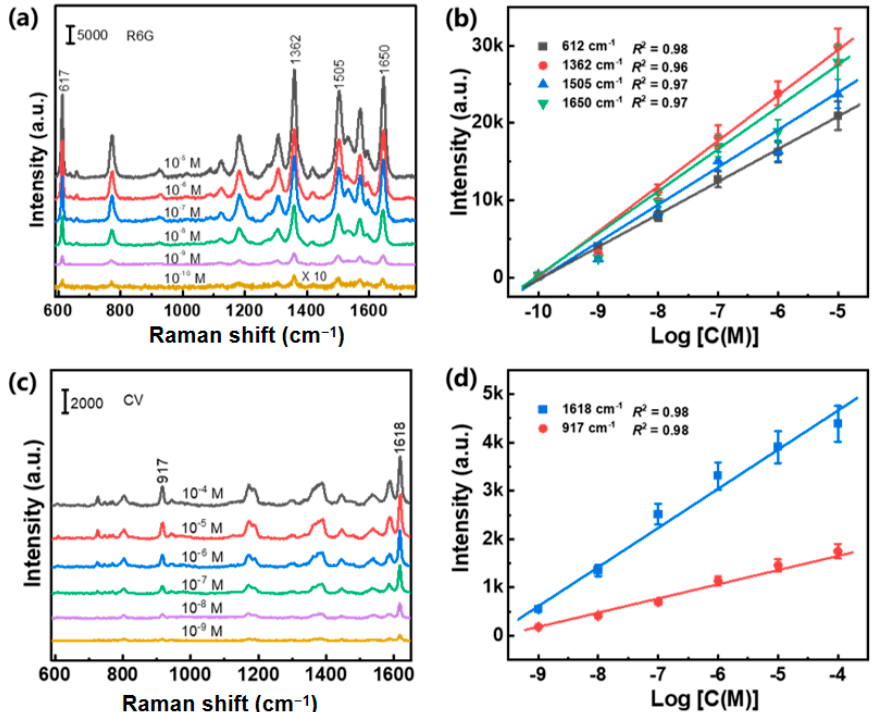
Figure 9. The concentration-dependent SERS spectra of R6G ( a ) and CV ( c ) acquired from the Au/CuS hybrid substrate. ( b , d ) The linear fitting of the SERS signal intensities of R6G at 612, 1362, 1505, and 1650 cm − 1 and CV at 917 and 1618 cm − 1 versus the logarithmic R6G and CV concentration. R is the correlation coefficient. Error bars were calculated from 20 different spectra.